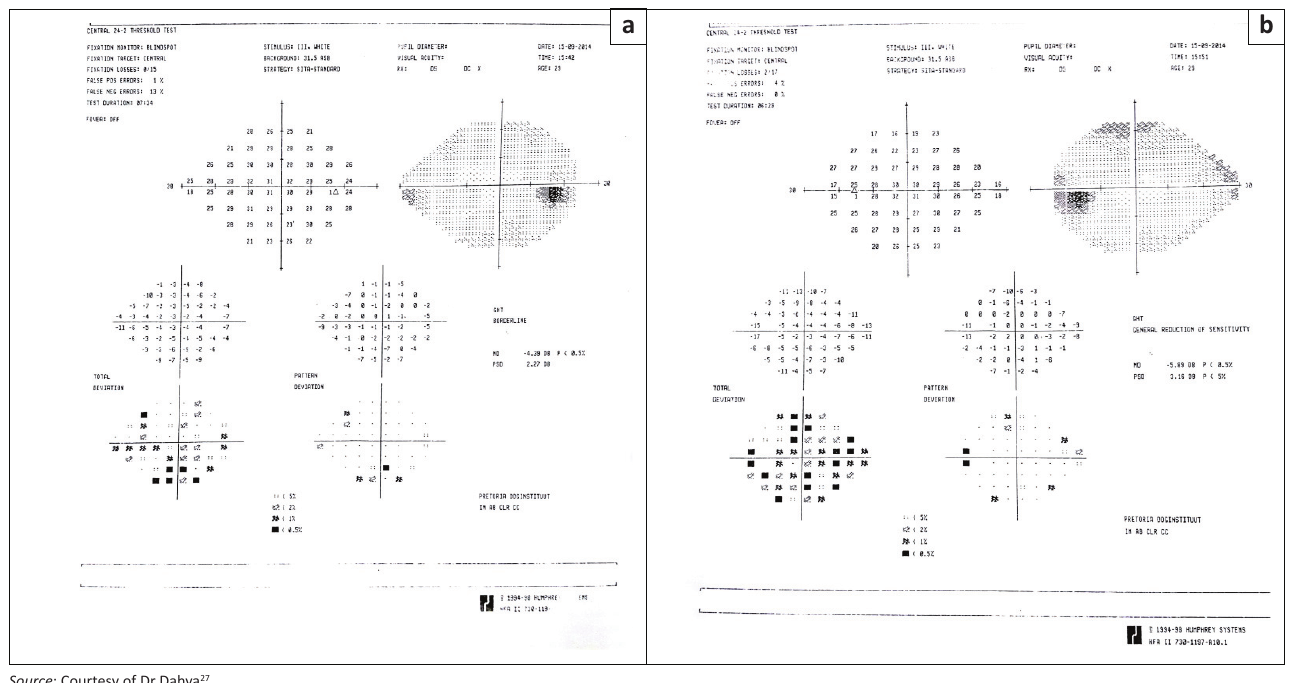
FIGURE 2: Showing a baseline field of the (a) right eye and (b) left eye with mild visual field loss in